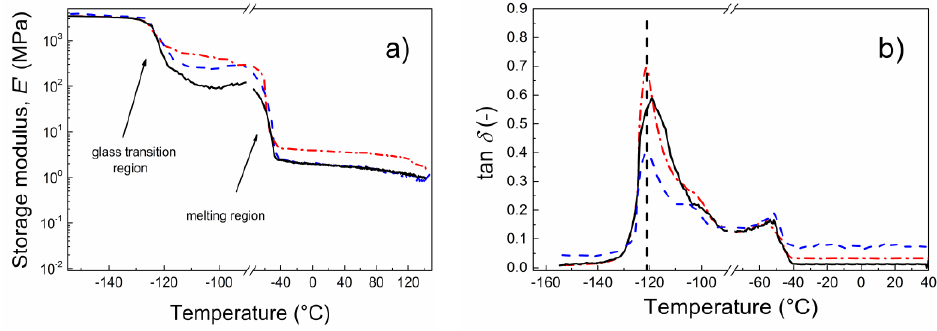
Figure 8. Dependence of the storage modulus ( a ) and tan δ ( b ) for broad temperature range for neat PDMS (black solid line) and for PDMS composites containing 0.1 vol % of neat GO (red dash dot line) and GO-PGMA 2 (blue dashed line).